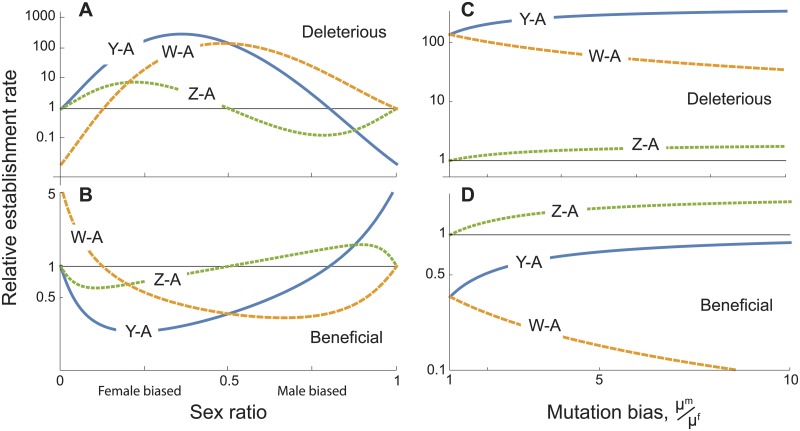
Establishment rates of sex chromosome-autosome fusions under direct selection, relative to the rate for X-A fusions.(A), (B) Effect of sex ratio bias among reproductive adults, N
m/(N
f + N
m), assuming μ
m = μ
f. (C), (D) Effect of the relative mutation rate for fusions in males versus females, μ
m/μ
f, assuming N
f = N
m. Mutations are deleterious (s = -0.0003) in panels (A), (C) and beneficial (s = 0.0003) in panels (B), (D). Parameters: N
f + N
m = 10000.